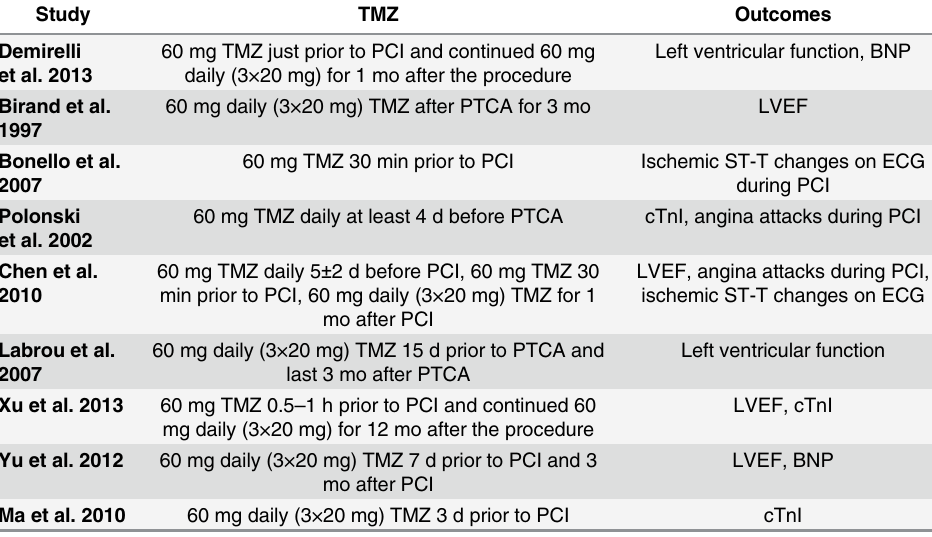
Table 2. TMZ Administration and Related